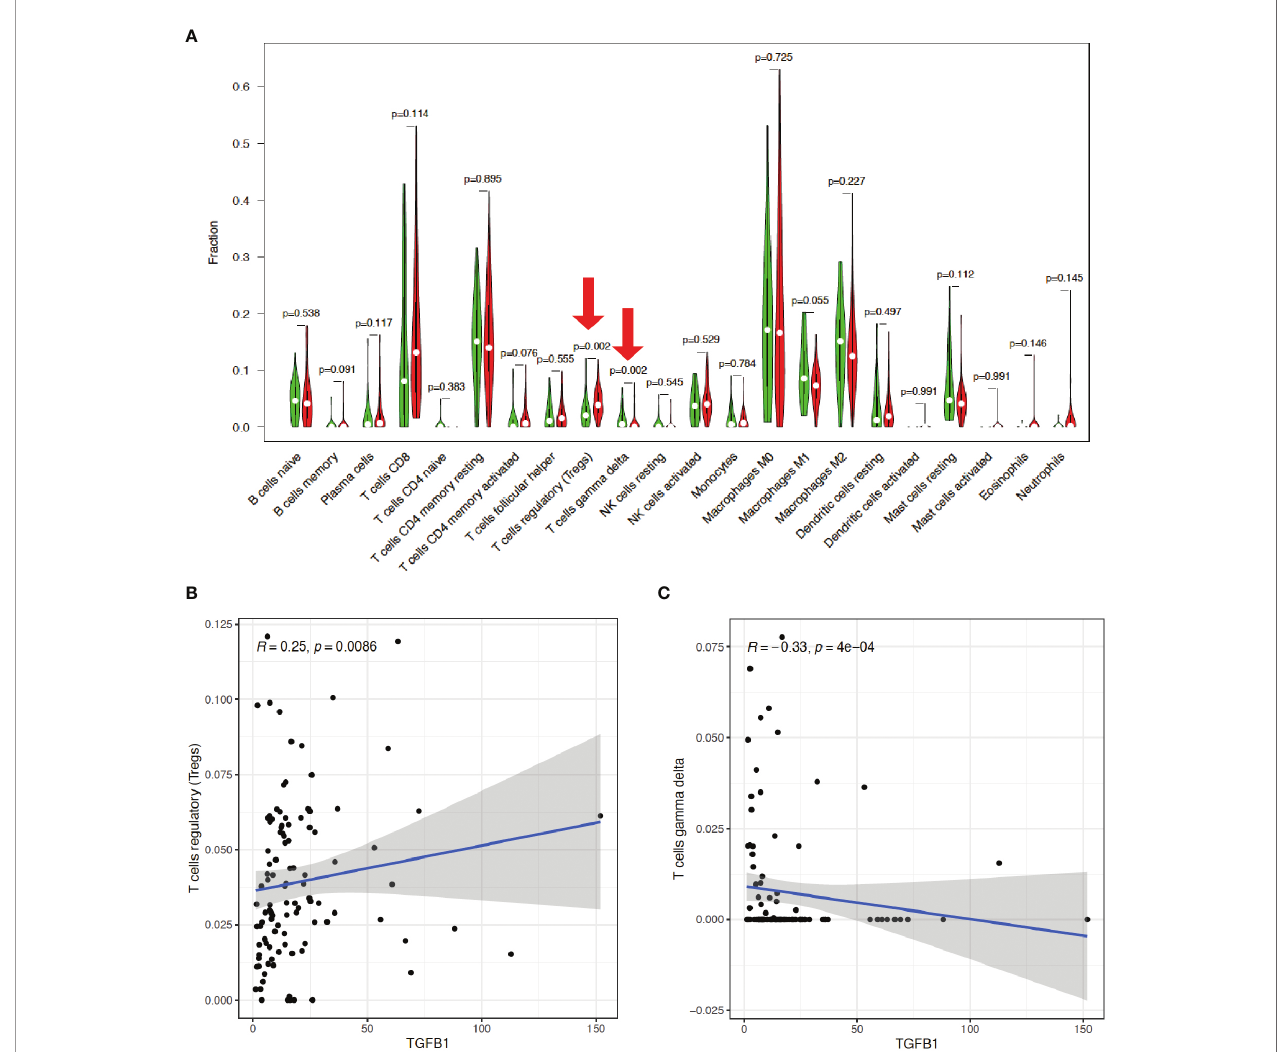
FIGURE 8 | TGF- b 1 expression is positively correlated with Tregs, but negatively correlated with gd T cells. (A) Differential analysis of the percentage ( y -axis) of the 22 types of immune cells ( x -axis) in HCC patients with high (indicated by red violins) or low (indicated by green violins) TGF- b 1 expression by using limma and vioplot packages. The red arrows suggested statistical signi fi cance ( p < 0.05). Correlation analysis of TGF- b 1 expression with Tregs (B) and gd T cells (C) by using limma, ggplot2, ggpubr, and ggextra packages. One black dot indicates one HCC sample. The blue lines indicate positive (B) or negative (C) correlation between TGF- b 1 expression and immune cell percentage. R : correlation coef fi cient. p < 0.05 suggests signi fi cant correlation between TGF- b 1 expression and immune cell